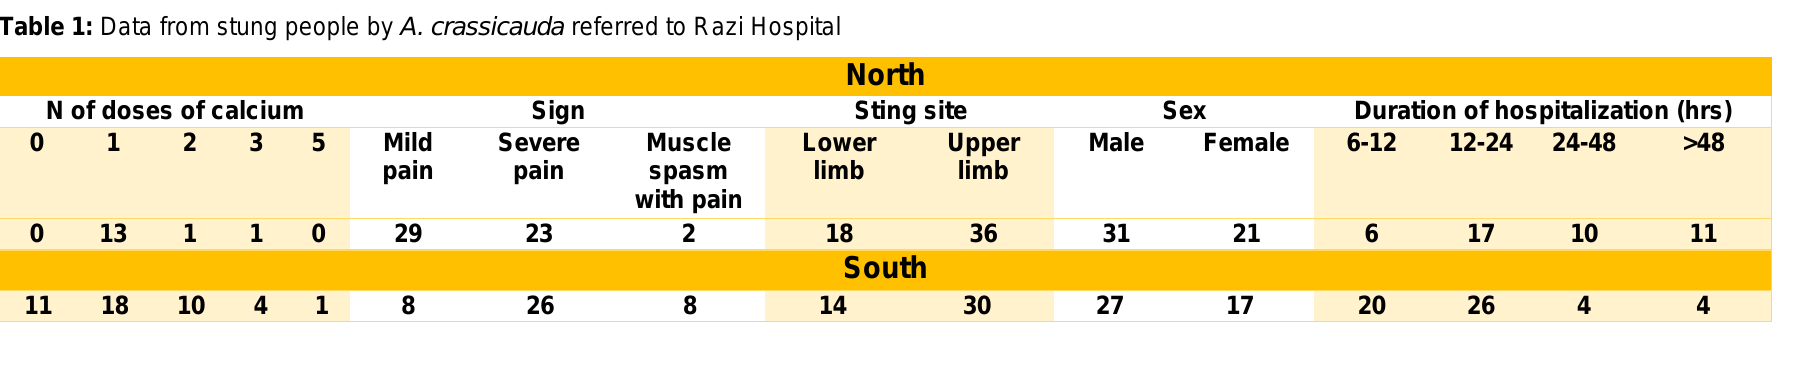
Table 2: Relationship between residency of patients and five variables Relationship with residency of patients Variable P-value in chi-square